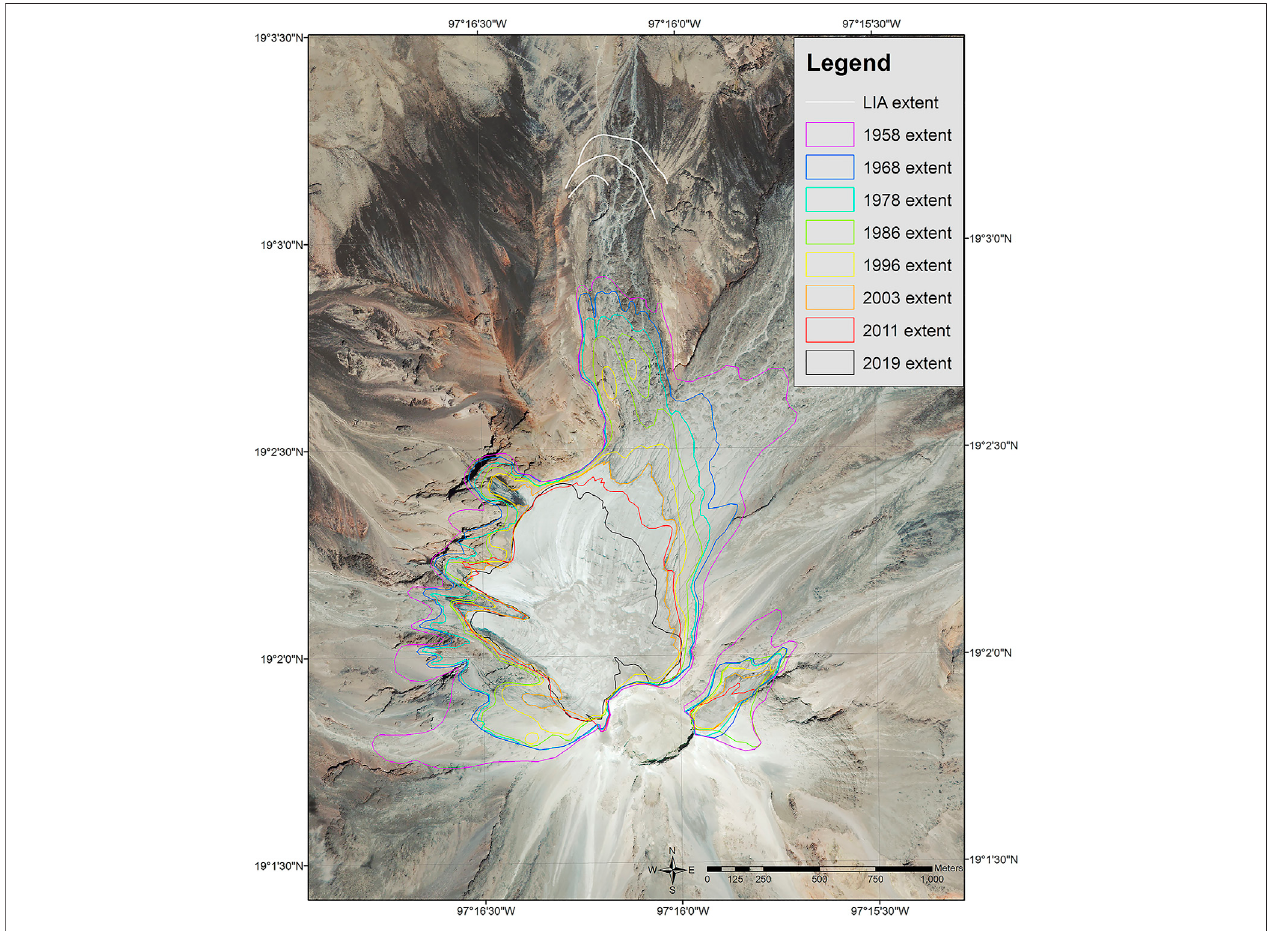
FIGURE 3 | Ikonos satellite image (2003) of Citlaltépetl´s summit and north face with overlays of glacier extents since the 1950 ’ s. Included are the mapped LIA terminal moraine ridges (white lines) as mapped by Palacios et al. (1999).